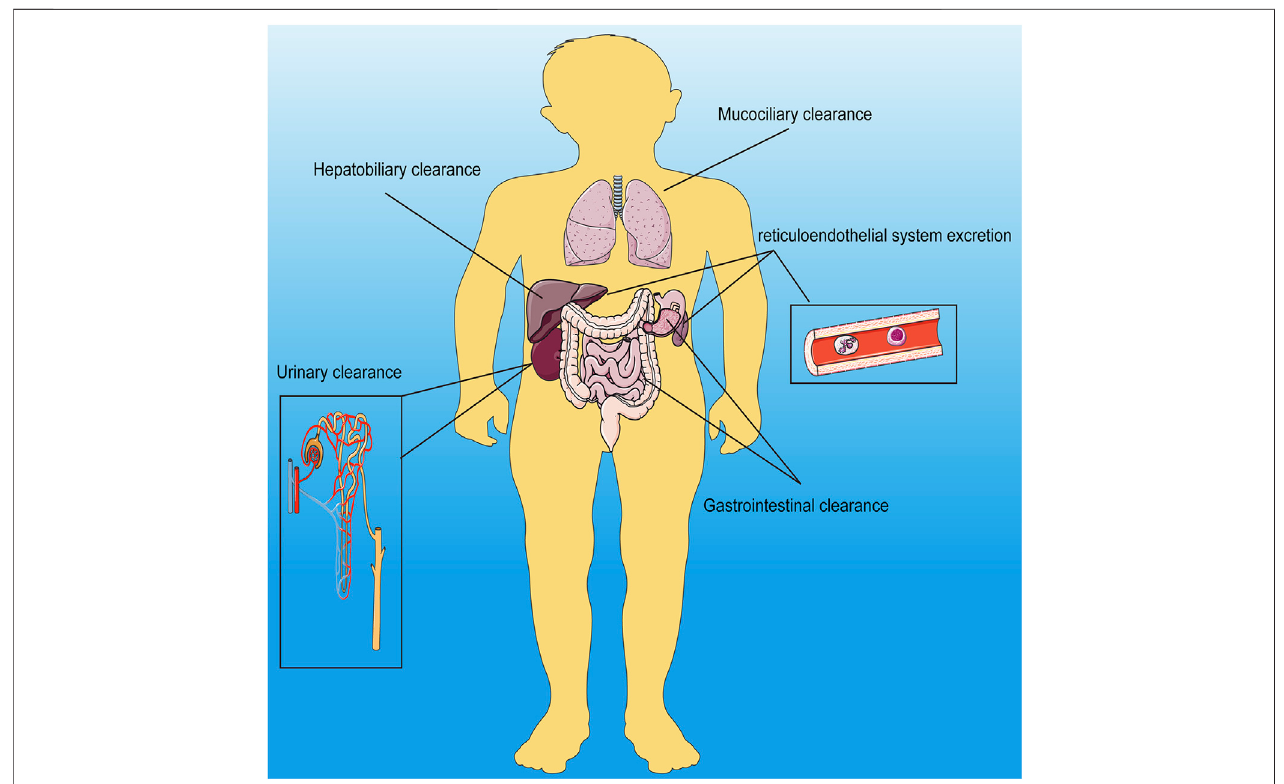
FIGURE 1 | Schematic diagram of the Q12 main metabolic pathways of inorganic nanomaterials in the body.